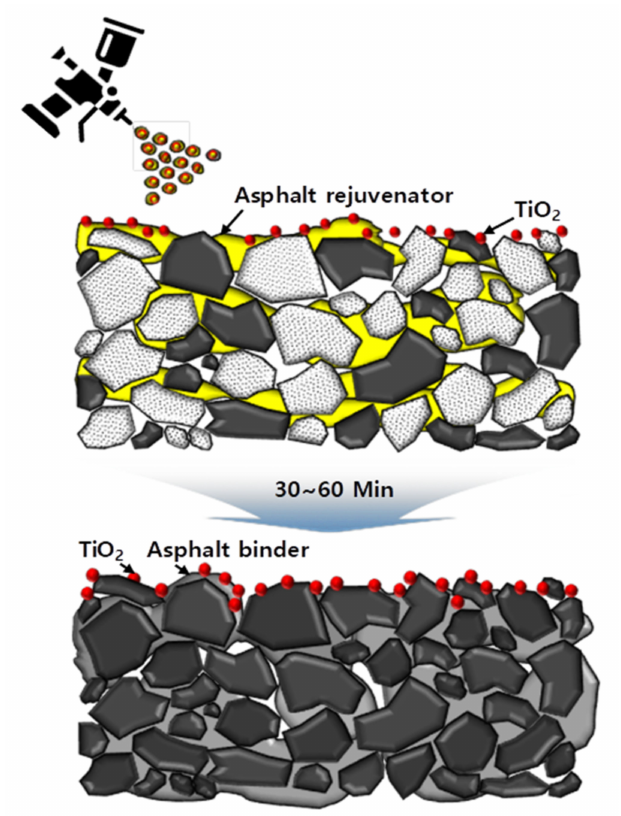
Figure 2. Coating mechanism of TiO 2.